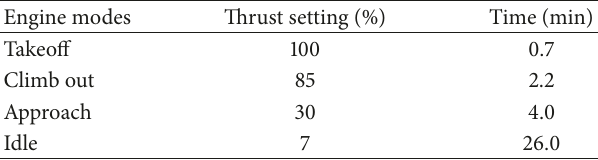
Table 2: ICAO landing-takeoff